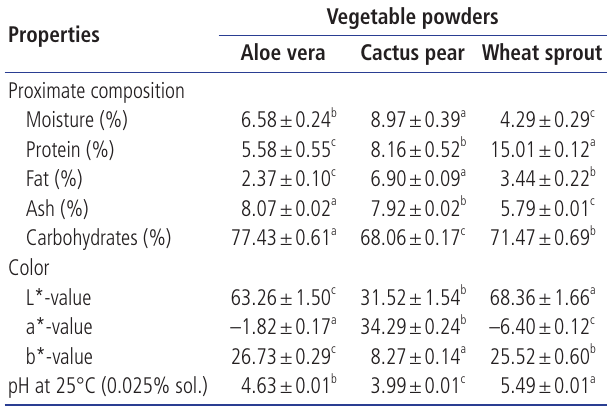
Table 2. The proximate composition, color and pH of vegetable